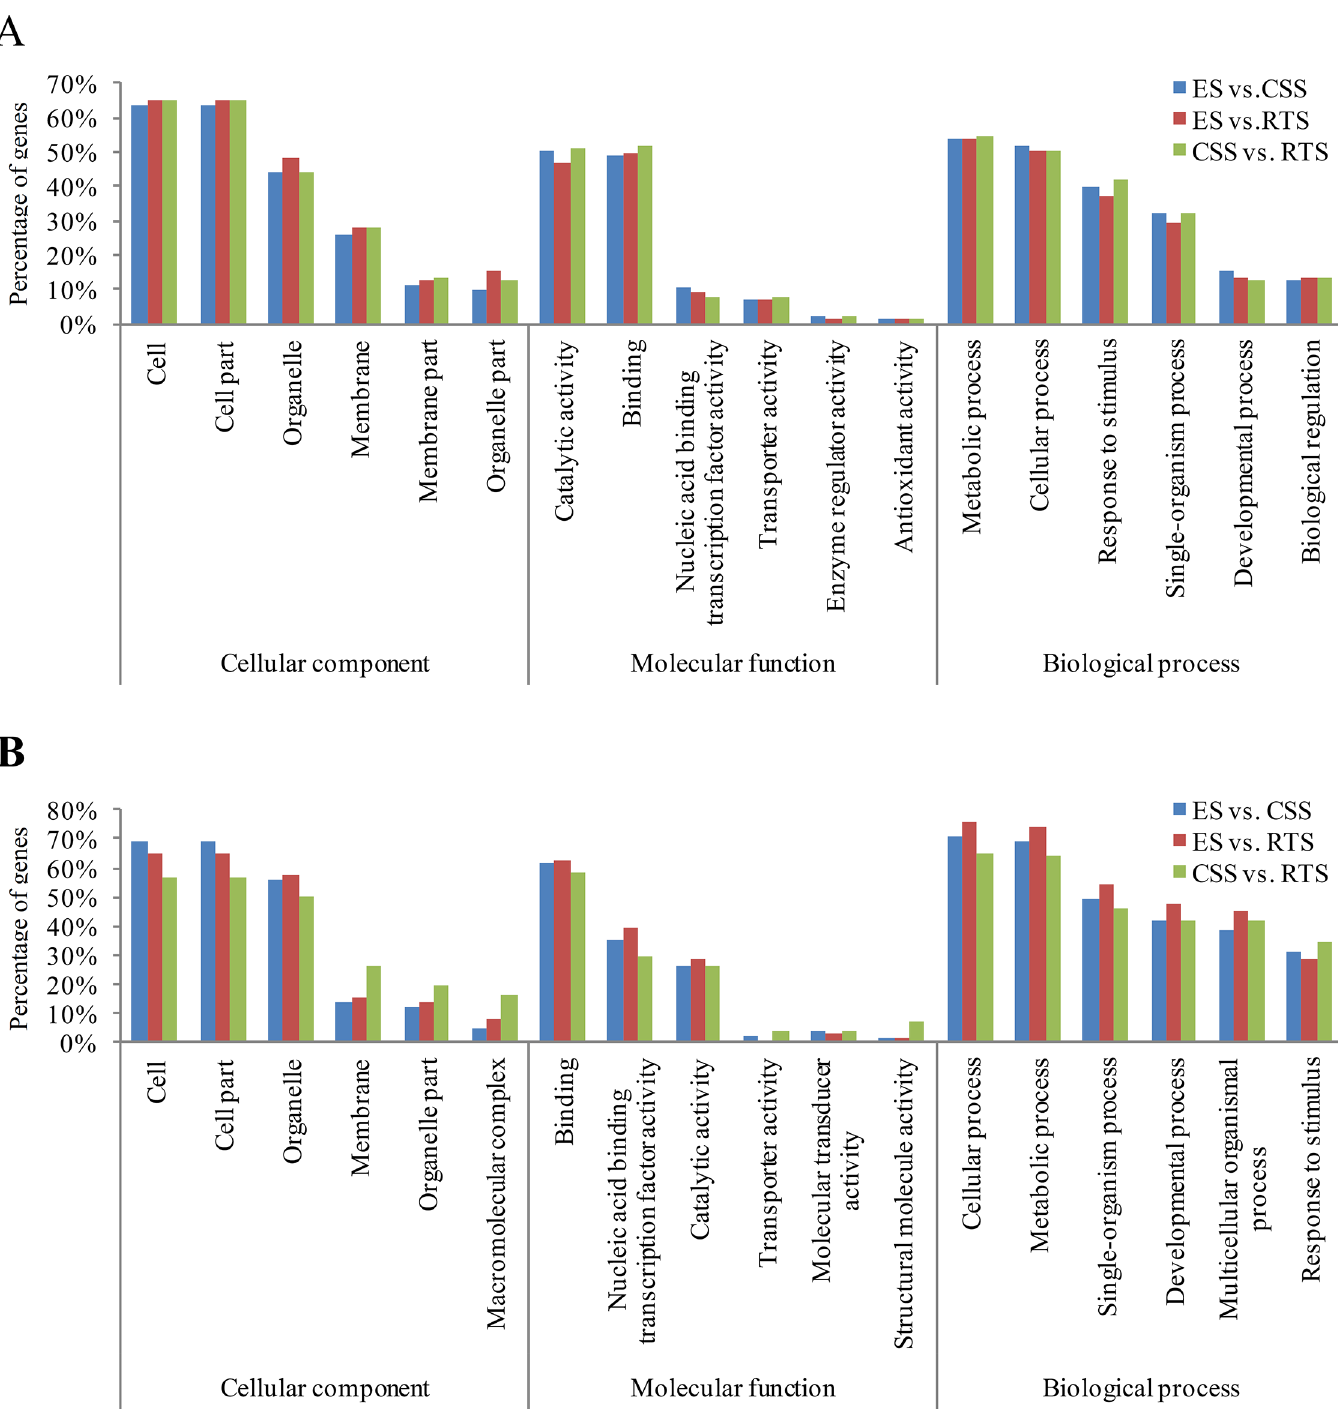
PLOS ONE | DOI:10.1371/journal.pone.0137983 September 14,